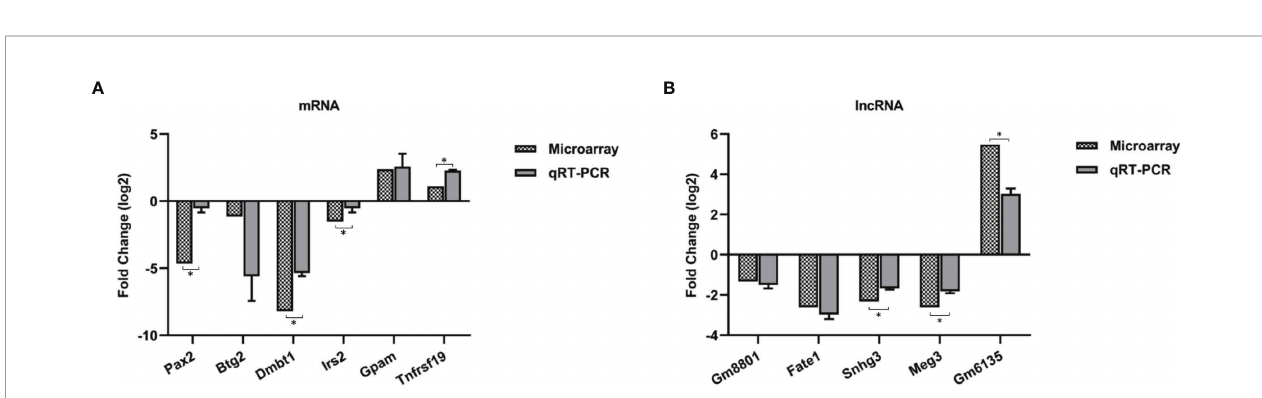
FIGURE 3 | Validation for the expression of 6 differentially expressed mRNAs (A) and 5 lncRNAs (B) by qRT-PCR. Three biological repeats were included in each gene. *p <